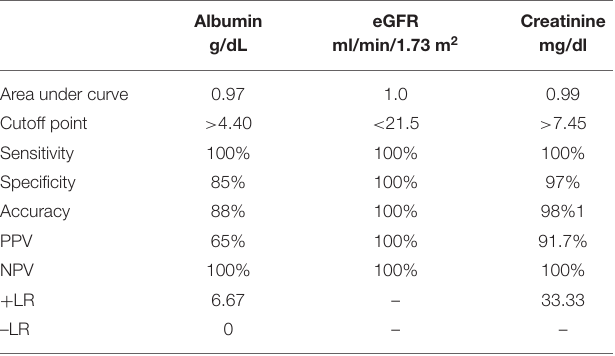
TABLE 5 | Validity of albumin, eGFR, and creatinine in diagnosis of peripheral neuropathy.